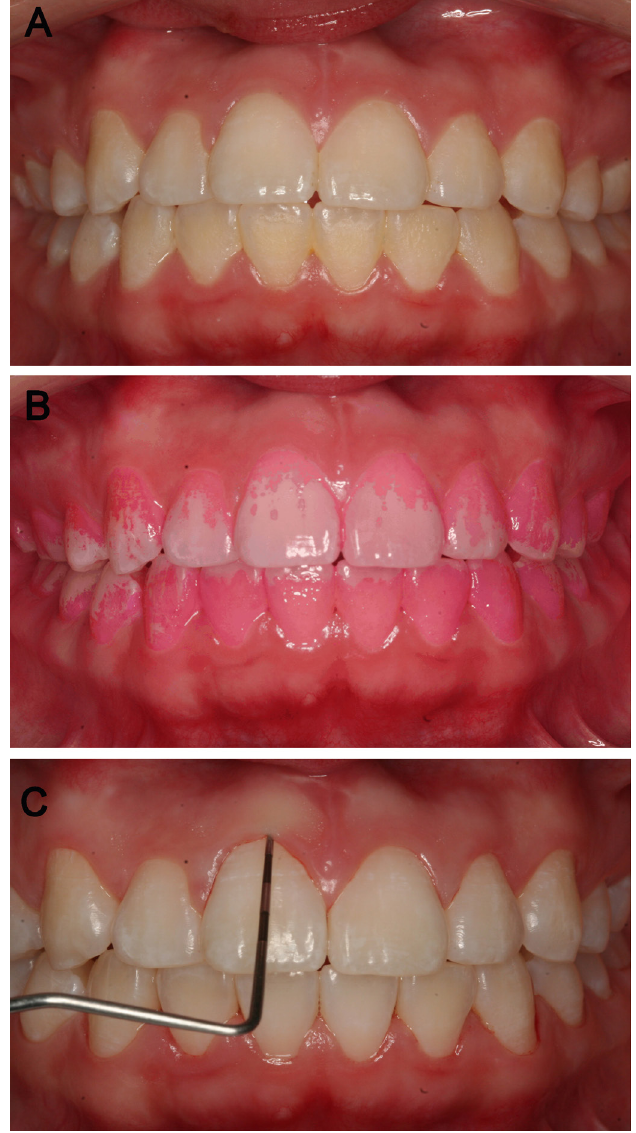
Fig.1. Intra-oral examination for the following clinical parameters: (A) visible Plaque Index (PI); (B) Disclosed Plaque Index (DPI), and (C) Gingival Bleeding Index (GBI).